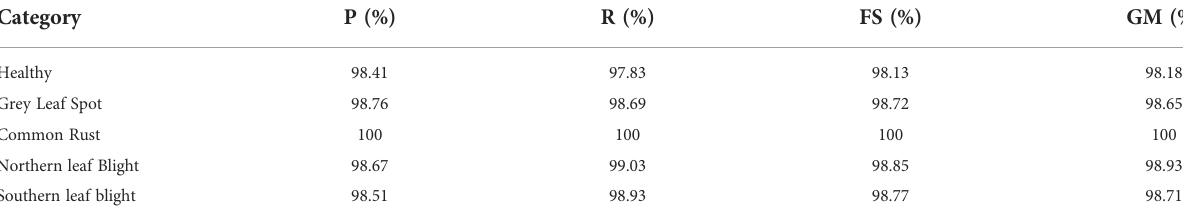
TABLE 4 The class-wise quantitative assessment outcomes of the EANet model.